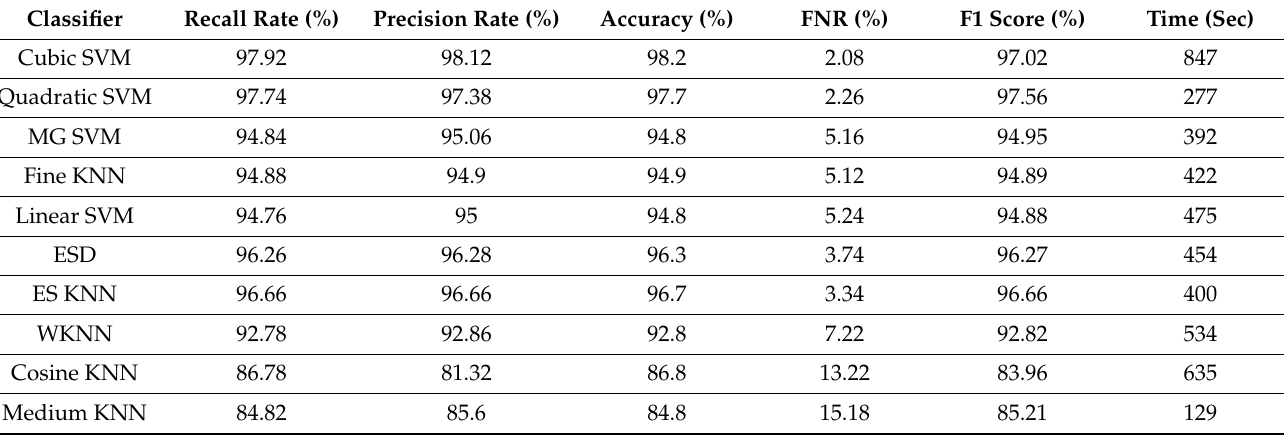
Table 8. Classification results using proposed parallel features fusion and Entropy-ELM selection of all pre-trained deep models using augmented